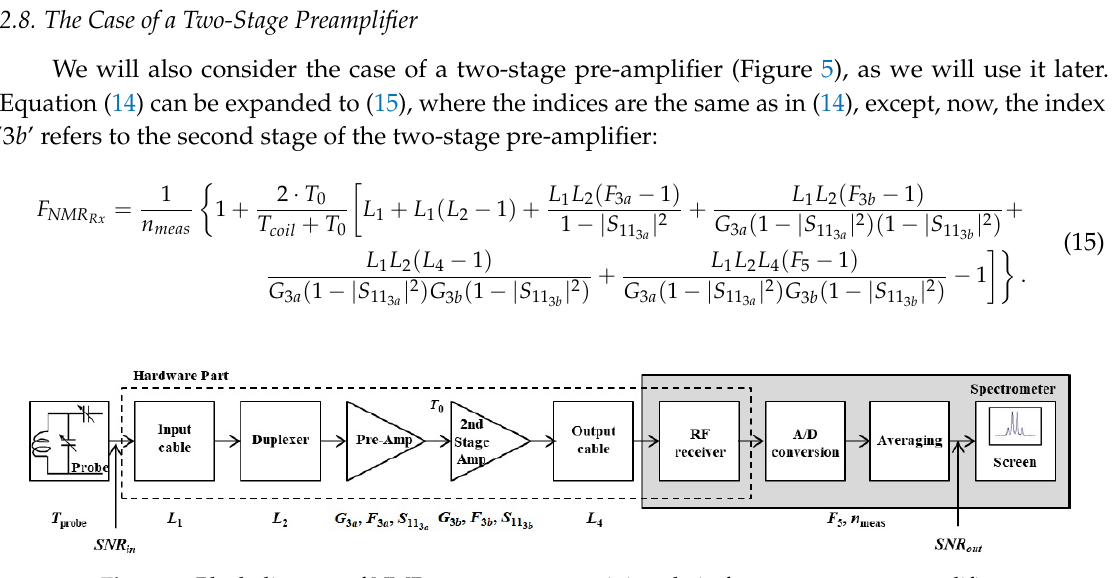
Figure 5. Block diagram of NMR spectroscopy receiving chain for a two-stage